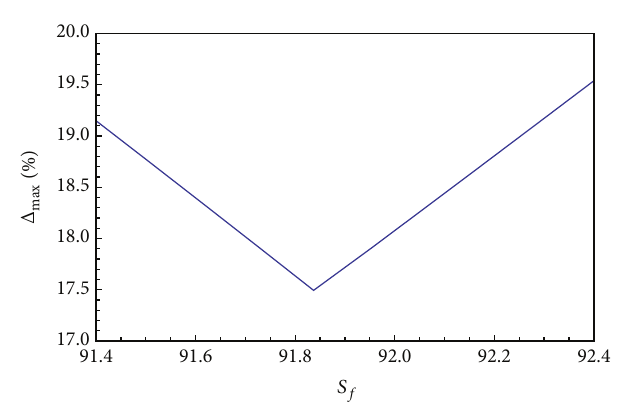
Figure 2: Same as Figure 1 for 𝑝